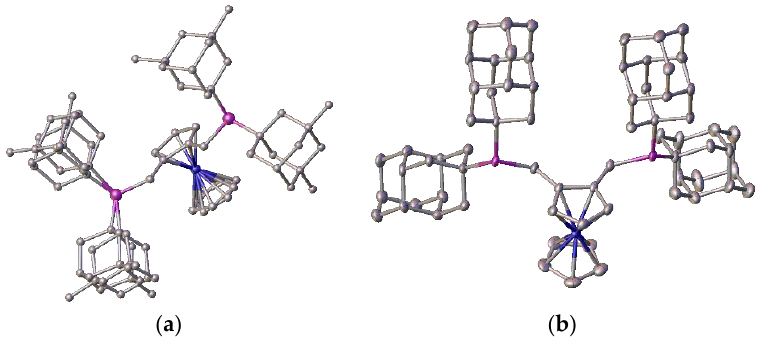
Figure 18. Ferocenylbisphosphine ligands: ( a ) 2c (3,5-dimethyladamantyl, local disorder in one pendant arm) and ( b ) 2f (dicongressyl), showing the steric bulk of the phosphine substituents. 2.2. Catalyst Testing: Initial Evaluation of Ferrocene-Based Ligands vs. Alpha Ligand in the Palladium-Catalysed Formation of Methyl Propanoate from Ethene, CO, and Methanol